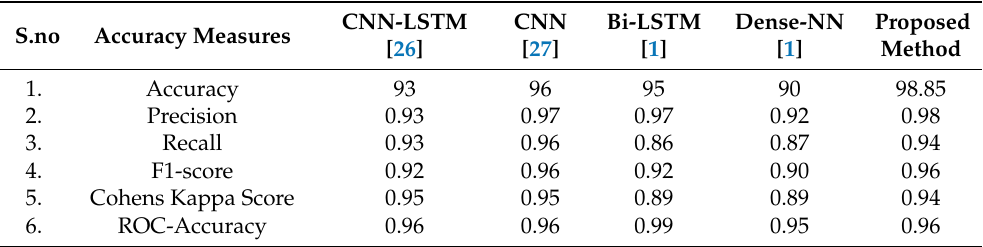
Table 10. A Comparative Study of various Deep Learning Algorithms for the Classification of Diabetes using 10-fold